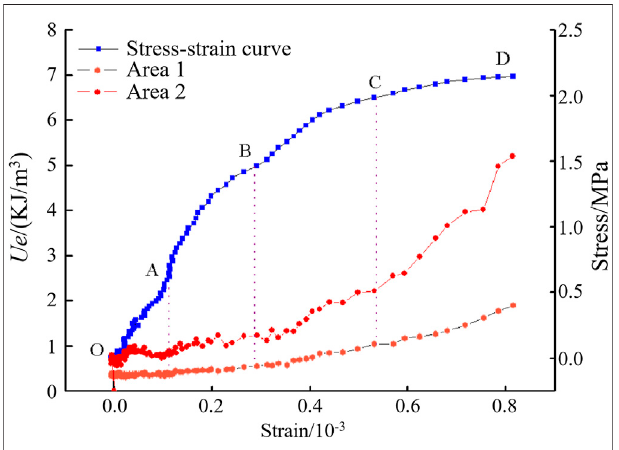
FIGURE 10 | Elastic strain energy evolution of S3